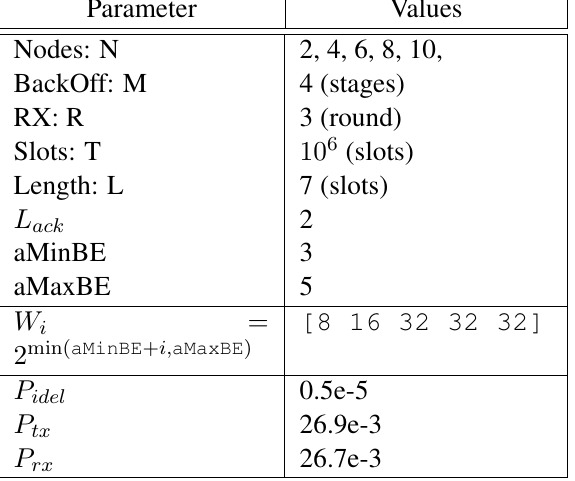
Table 3. The parameters for the simulation and the WPAN